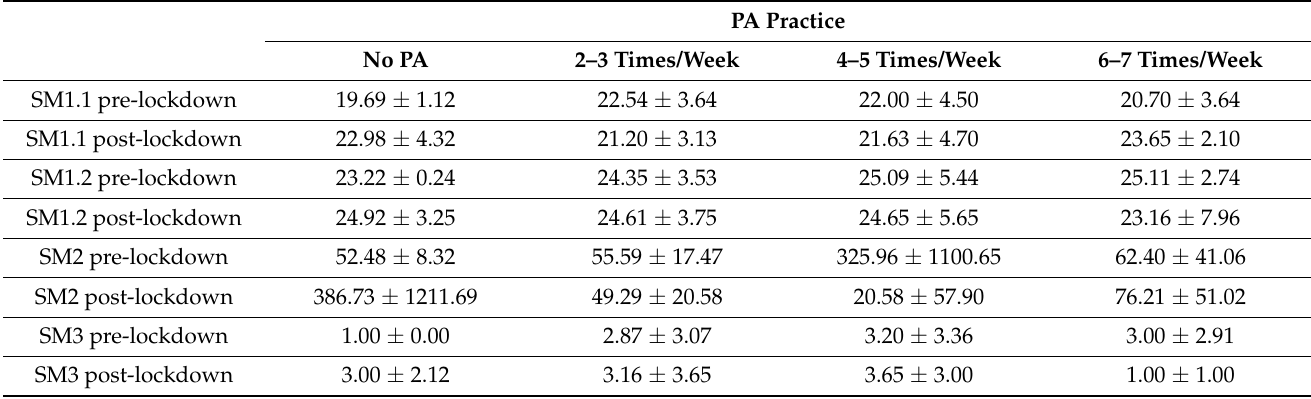
Table 2. Pre- and post-lockdown manual dexterity test scores in relation to the frequency of children who were not physically active using descriptive analysis.